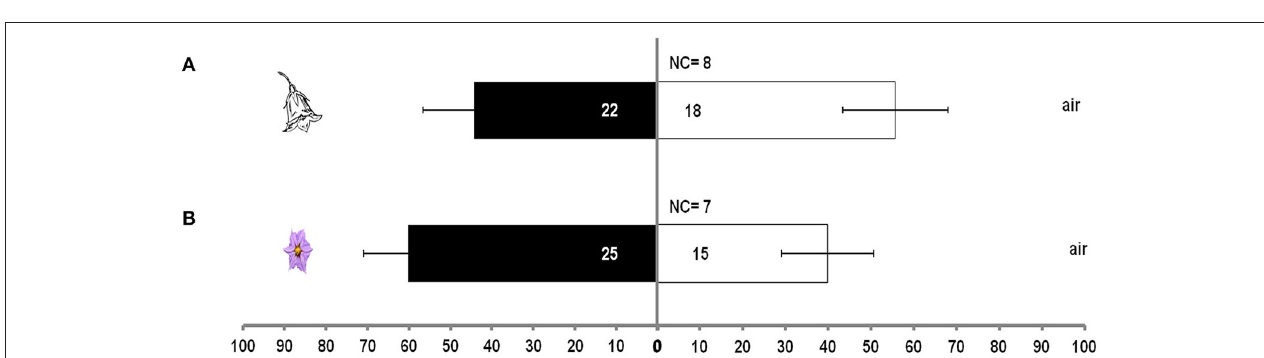
FIGURE 1 | Response of M. pygmaeus nymphs originating from pepper (A) or aubergine (B) plants in a Y-tube olfactometer to the odors of pepper plant, aubergine and clean air for each compared pair. Number in bars represent individuals that moved toward the odor source. t test (* P < 0.05; df : 1) (NC, number of individuals that did not make a choice).